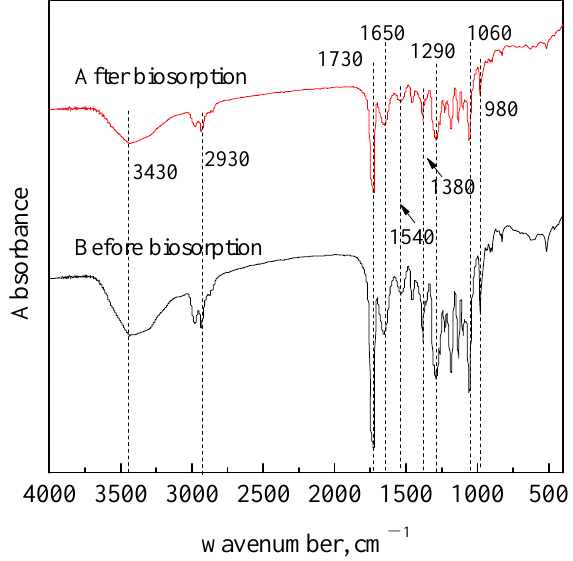
Figure 1. FTIR spectrum of bacterial biomass before and after the biosorption of phenanthrene.